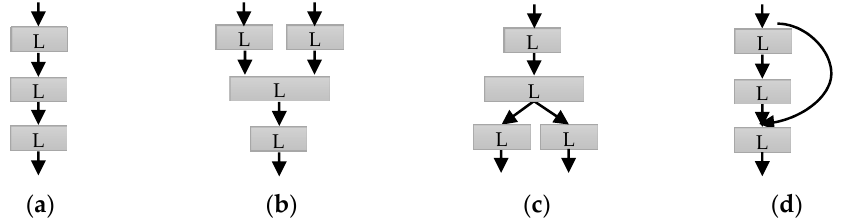
Figure 10. ( a ) Sequential block, ( b ) concatenation block ( c ) expansion block and ( d ) residual inception block.